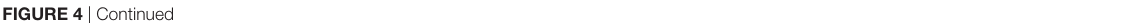
FigUre 4 | Continued Characteristics of APECED patients and Protoarray reactivities. (a) Clustering patients and z -scores for the 50 most commonly recognized autoantigens using hierarchical clustering algorithm. (B) Clustering patients (columns) according to their clinical manifestations (rows). Red squares represent the presence of a given manifestation, while white and gray show absence of manifestation and missing information, respectively. (c) Positive correlation between the number of manifestations and the number of autoantigens ( z > 3, logarithmized), correlation coefficient ~0.29. (D) Analysis of longitudinal serum samples taken at different time points. Blue squares and connecting lines ( n = 11) correspond to samples with increased number of autoantigens and red squares and connecting lines ( n = 3) correspond to samples with decreased or unchanged number of autoantigens. Each line and connected squares correspond to one APECED patient with samples collected at different time points. The locations of the squares on y -scale correspond to the age of the patient when the samples were collected. The sizes of the blue and red squares correspond to the number of positive autoantigens in corresponding samples. (e) The change of autoantigen profiles in samples collected longitudinally. The two columns show the autoantibody reactivities in patient samples taken less than 10 or more than 10 years apart. The autoantigens were compared between the samples of the same patient and divided into three categories according to their specificity: (i) specific to early sample, (ii) shared in early and late sample, and (iii) specific to late sample. The numbers in columns indicate the proportions of each category. Samples taken more than 10 years apart show higher percentage of autoantigens in the late samples, indicating that the autoantibody repertoire gets broader with